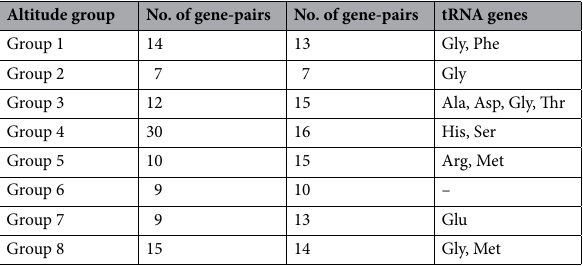
Table 5. The number of genes and genes pairs in each altitude group along with the specific tRNA